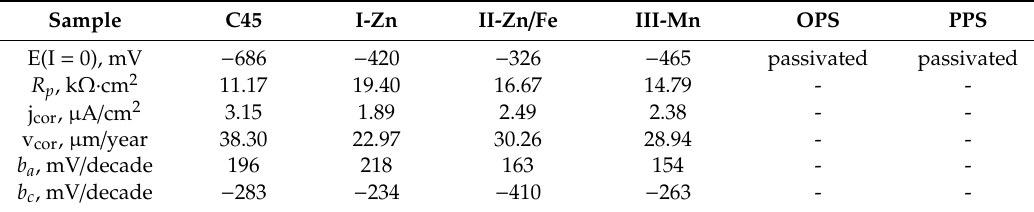
Table 2. Parameters of the instantaneous corrosion process for the samples studied in rainwater.